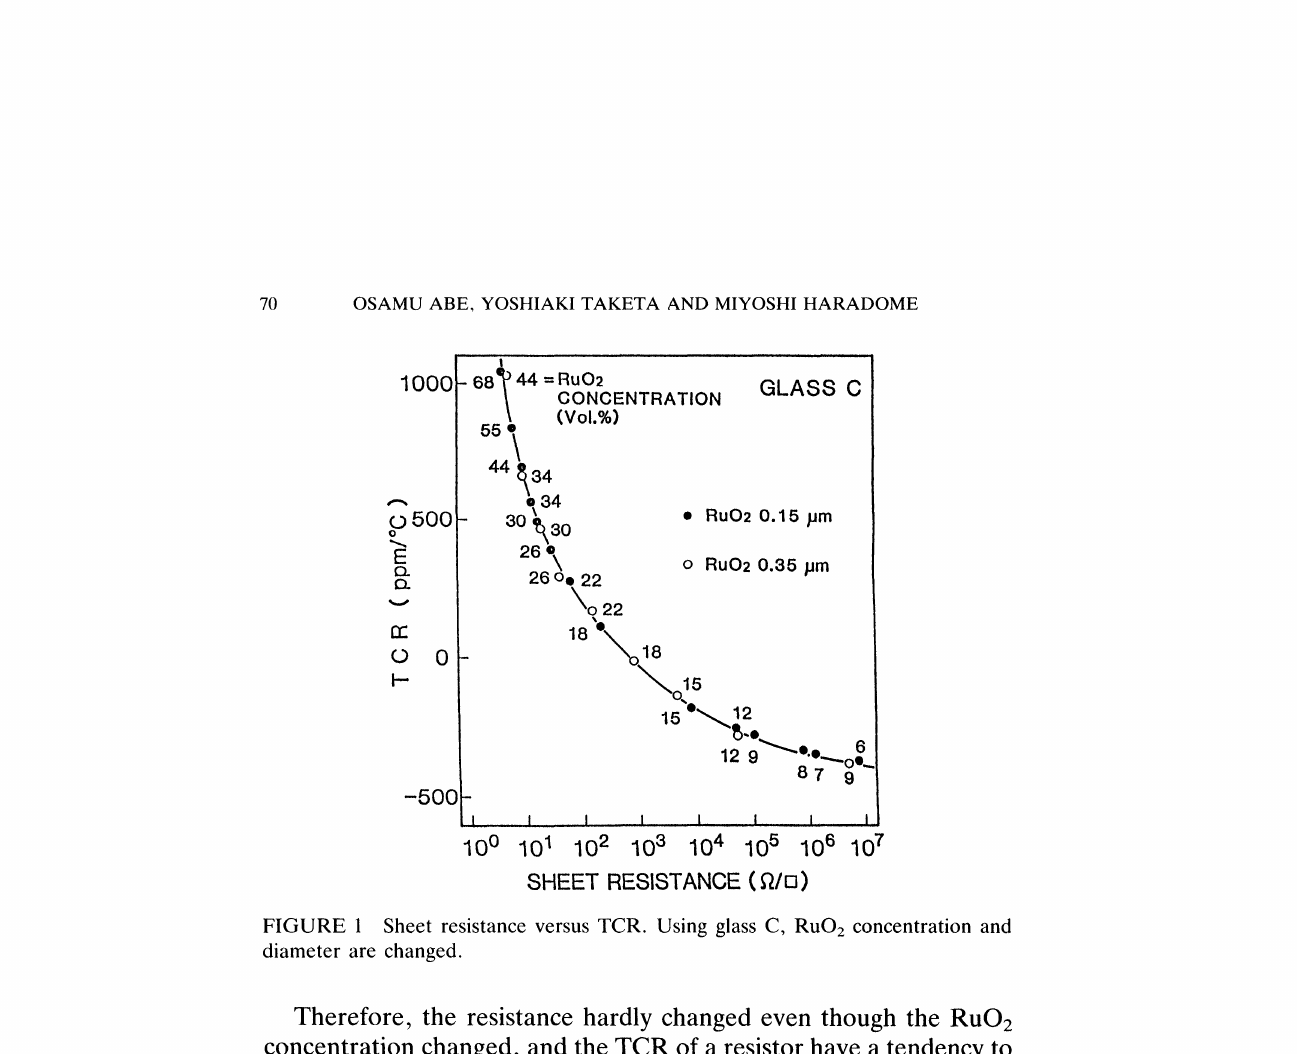
FIGURE Sheet resistance versus TCR. Using glass C, RuO concentration and diameter are